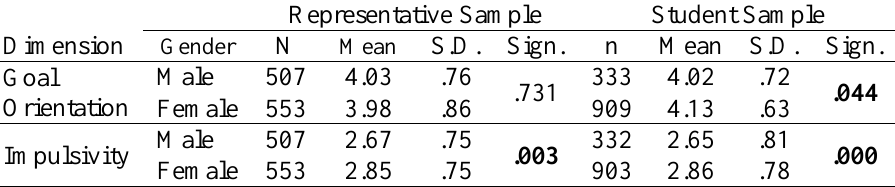
Gender differences in ScSRQ-CZ of the representative and the student samples Representative Sample Student Sample Dimension Gender N Mean S.D. Sign. n Mean Sign. Goal